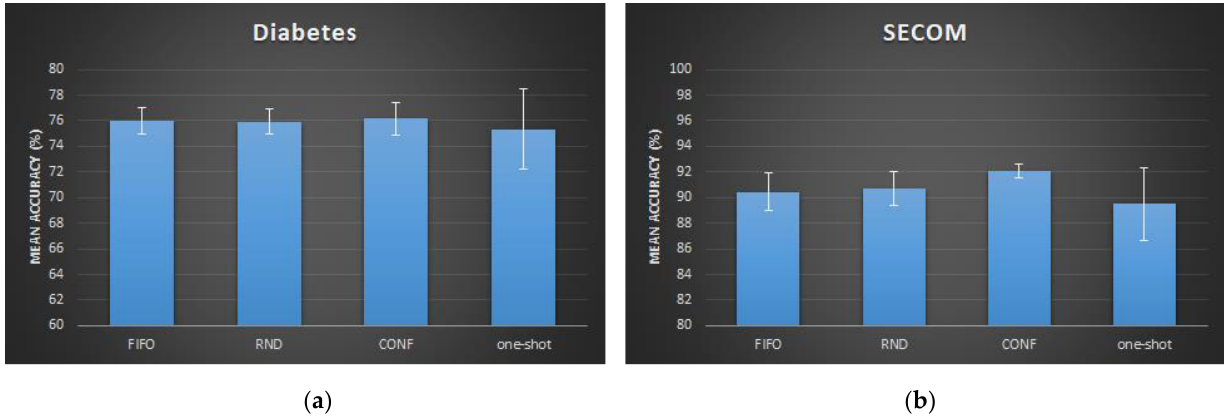
Figure 9. Mean accuracy with standard deviation bars of AutoKNN on ( a ) diabetes and ( b ) SECOM datasets with different memory approaches.